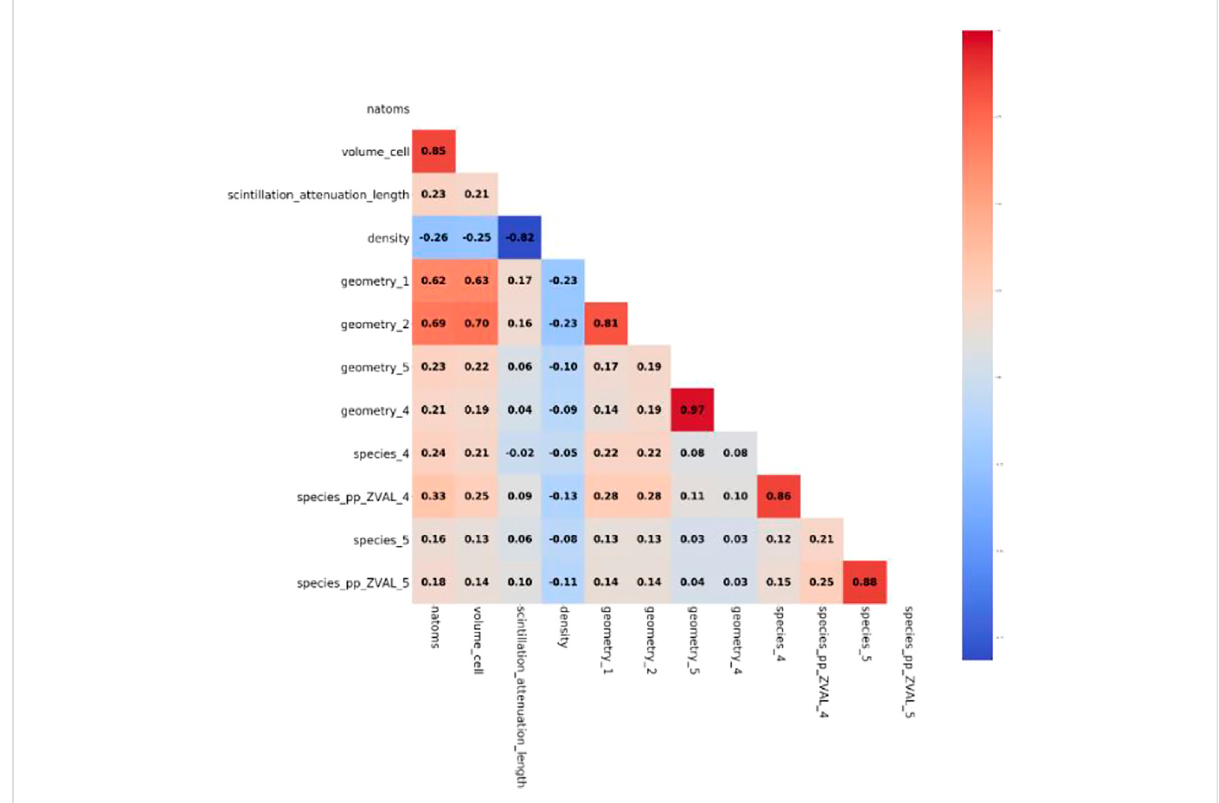
FIGURE 1 Heat map of features ’ pearson correlation coef fi